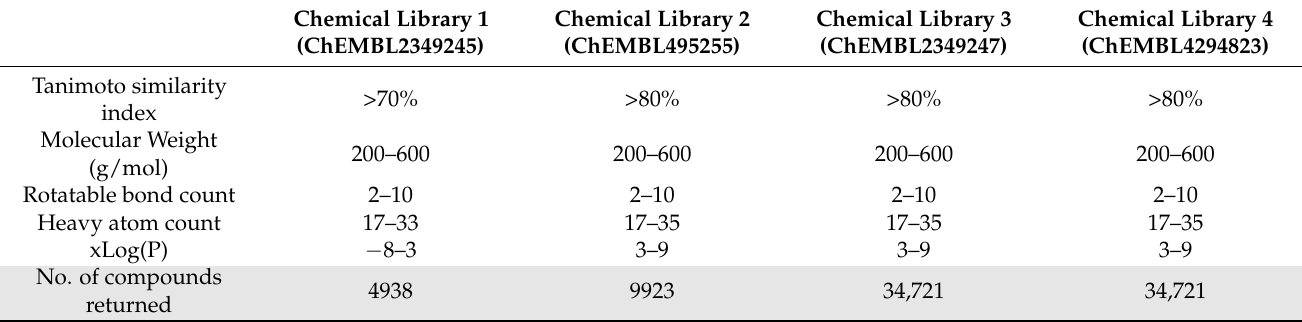
Table 4. Selection criteria of chemical libraries obtained from